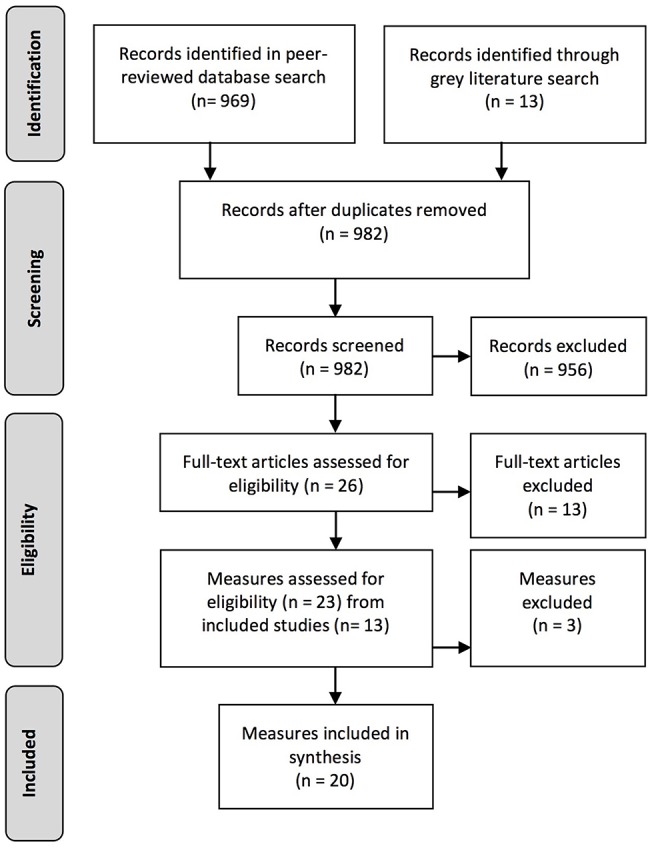
PRISMA flow chart.